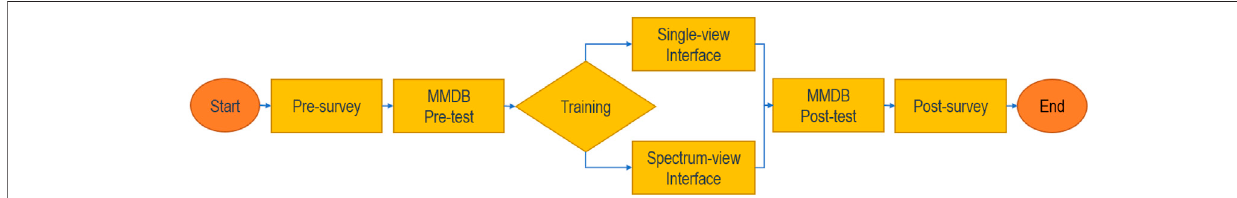
FIGURE 3 | Work fl ow diagram demonstrating the different stages of the study.